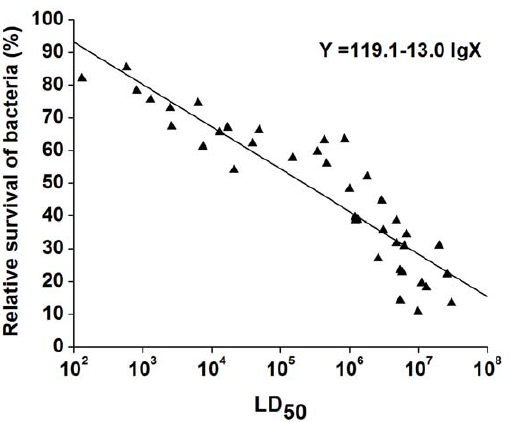
Figure 8. Linear regression model to predict relative survival of T. thermophila from LD 50 values of the Aeromonas isolates. Concentrations of Aeromonas and T. thermophila cells at the start of the experiment were 1 6 10 9 cells/ml and 2 6 10 5 cells/ml, respectively. LD 50 s of 39 Aeromonas isolates in zebrafish were used as the abscissa and a trend line was added. Each experiment was repeated a minimum of six times per time point. Data presented represent the mean of a four